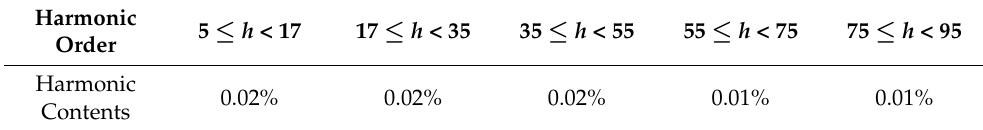
Table 5. Odd background harmonic voltage components.